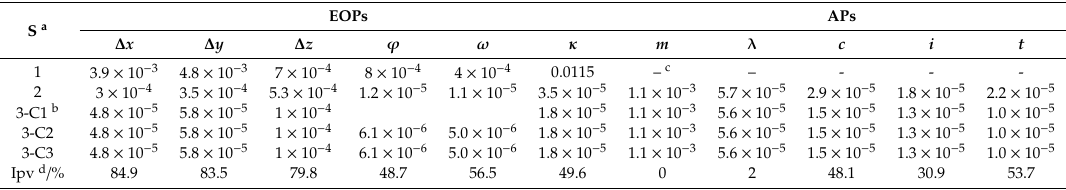
Table 3. RMSE of parameter vector.